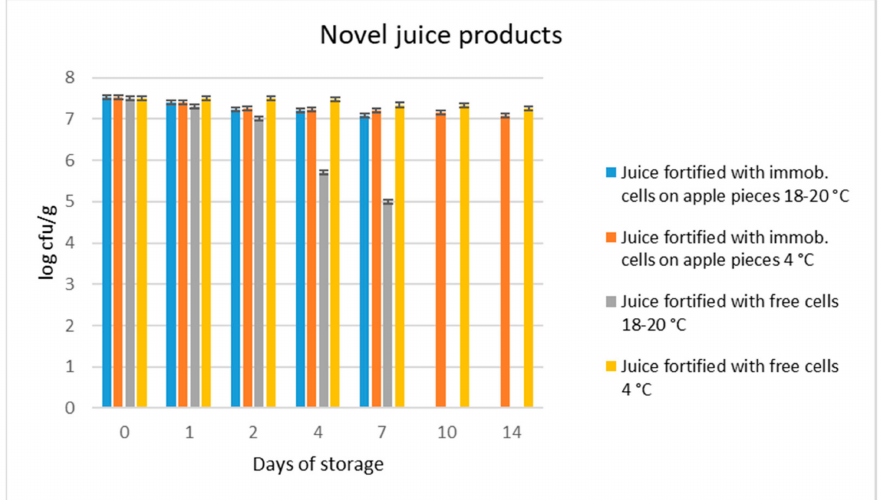
Figure 1. Populations (log cfu/g) of free or immobilized L. rhamnosus OLXAL-1 on apple pieces in novel functional juices after 2 weeks storage at 20 ◦ C or 4 ◦